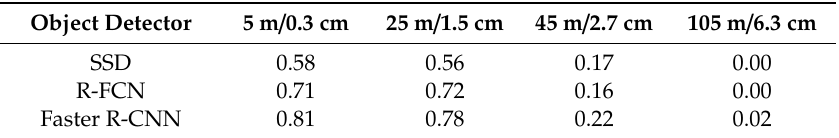
Table 8. Comparison of object detectors between di ff erent resolutions in the second setting, where we only evaluated the down-sampled images. The metric is MAP@0.5IoU.